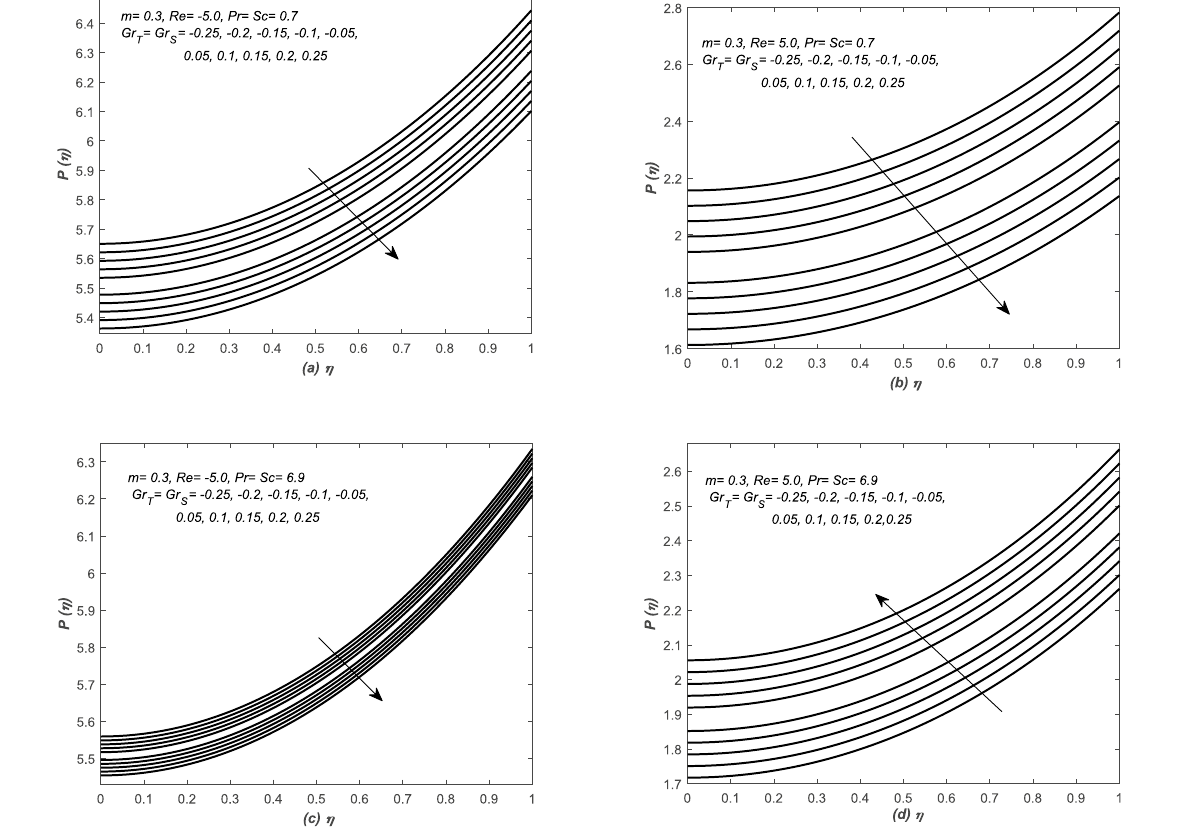
Figure 2. The dimensionless pressure or P (η) is plotted against η for various values of thermal and solutal Grashof numbers such that Gr T = Gr S . Note that these investigations are carried out for the flow of air and water in converging and diverging